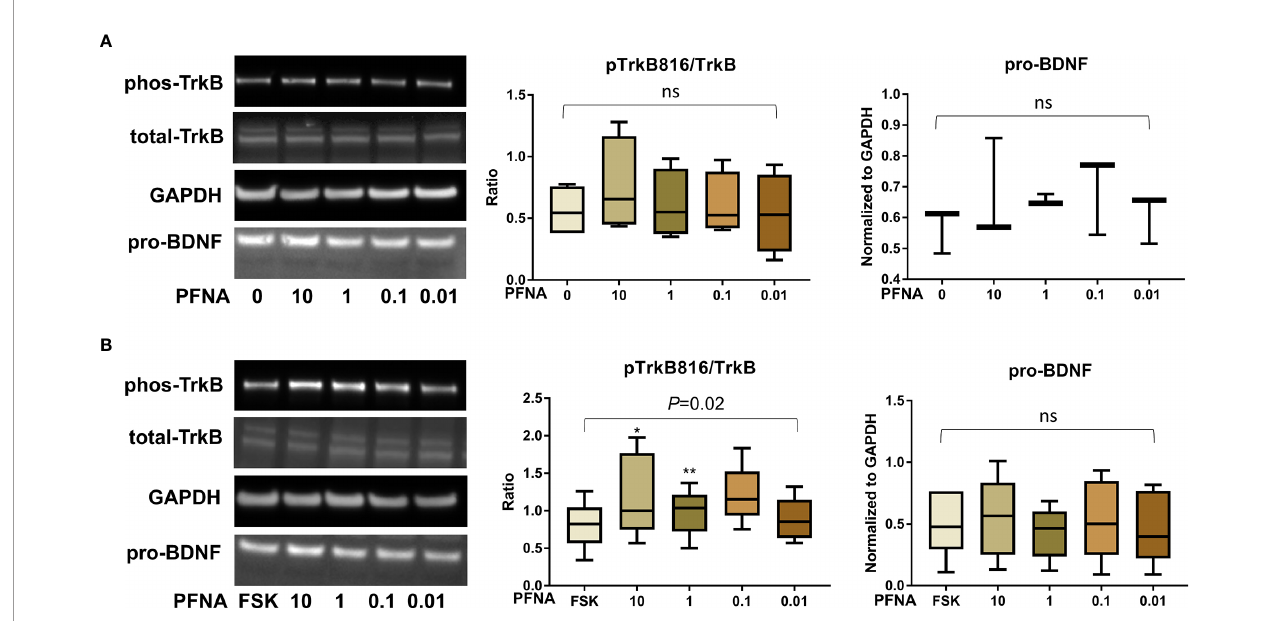
FIGURE 3 | Altered TrkB phosphorylation at high concentrations of PFNA. (A) Representative Western blot images of phos-TrkB, total-TrkB, GAPDH, and pro- BDNF in BeWo cells without forskolin (FSK) treatment exposed to PFNA (0, 0.01, 0.1, 1, and 10 µM) and box plots for densitometry analysis; (B) Representative Western blot images of phos-TrkB, total-TrkB, GAPDH, and pro-BDNF in BeWo cells with FSK treatment exposed to PFNA (0, 0.01, 0.1, 1, and 10 µM) and box plots for densitometry analysis. ns indicates differences in protein levels were not signi fi cant. pTrkB816 represents for phosphorylation of TrkB at Tyr816 residue.